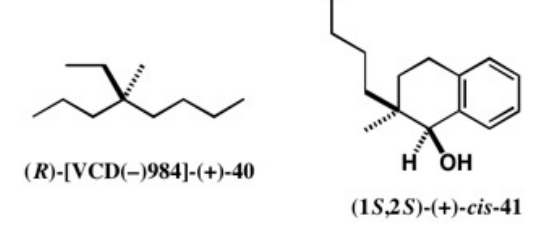
Figure 27. Cryptochiral hydrocarbon ( R )-[VCD( − )984]-(+)- 40 and synthetic precursor (1 S ,2 S )-(+)- cis - 41 .